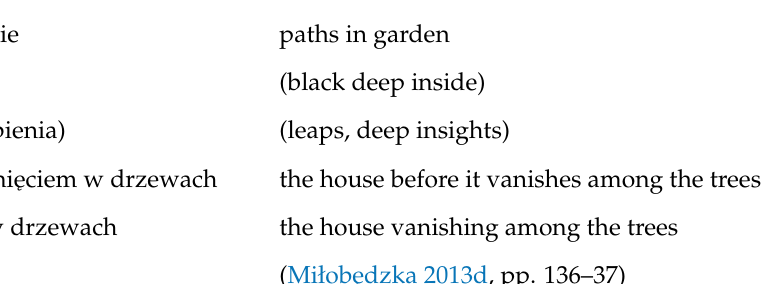
Figure 11. © photography by Pawe ł J ę drzejczak. Mural of a poem by Krystyna Mi ł ob ę dzka, wró ć i b ą d ź jeszcze dalej (come back and be still more) on the wall of library in Puszczykowo. The mural was made in a frame of project “M ł odzie ż w dzia ł aniu” (Youth in Action), coordinated by Magda Nowicka Chomsk.